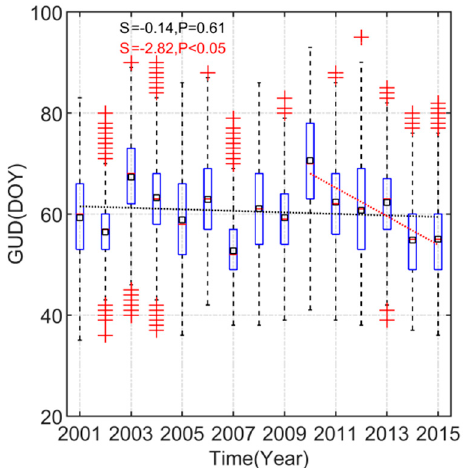
Figure 6. Interannual variations of regional GUD for 2001–2015. The bottom and top edges of each blue box indicate the 25th and 75th percentiles, respectively. The horizontal red line in each blue box represents the median values. The open black square in each blue box represents mean values. The black whiskers extend to the 1.5 times the interquartile range. Red crosses mean outliers. The black dot line is GUD trend during the period of 2001–2015, and the black texts in the upper left corner present the corresponding slope (S) and significance (P). The red dot line is GUD trend during the period of 2010–2015, and the red texts in the upper left corner present the corresponding slope (S) and significance (P).